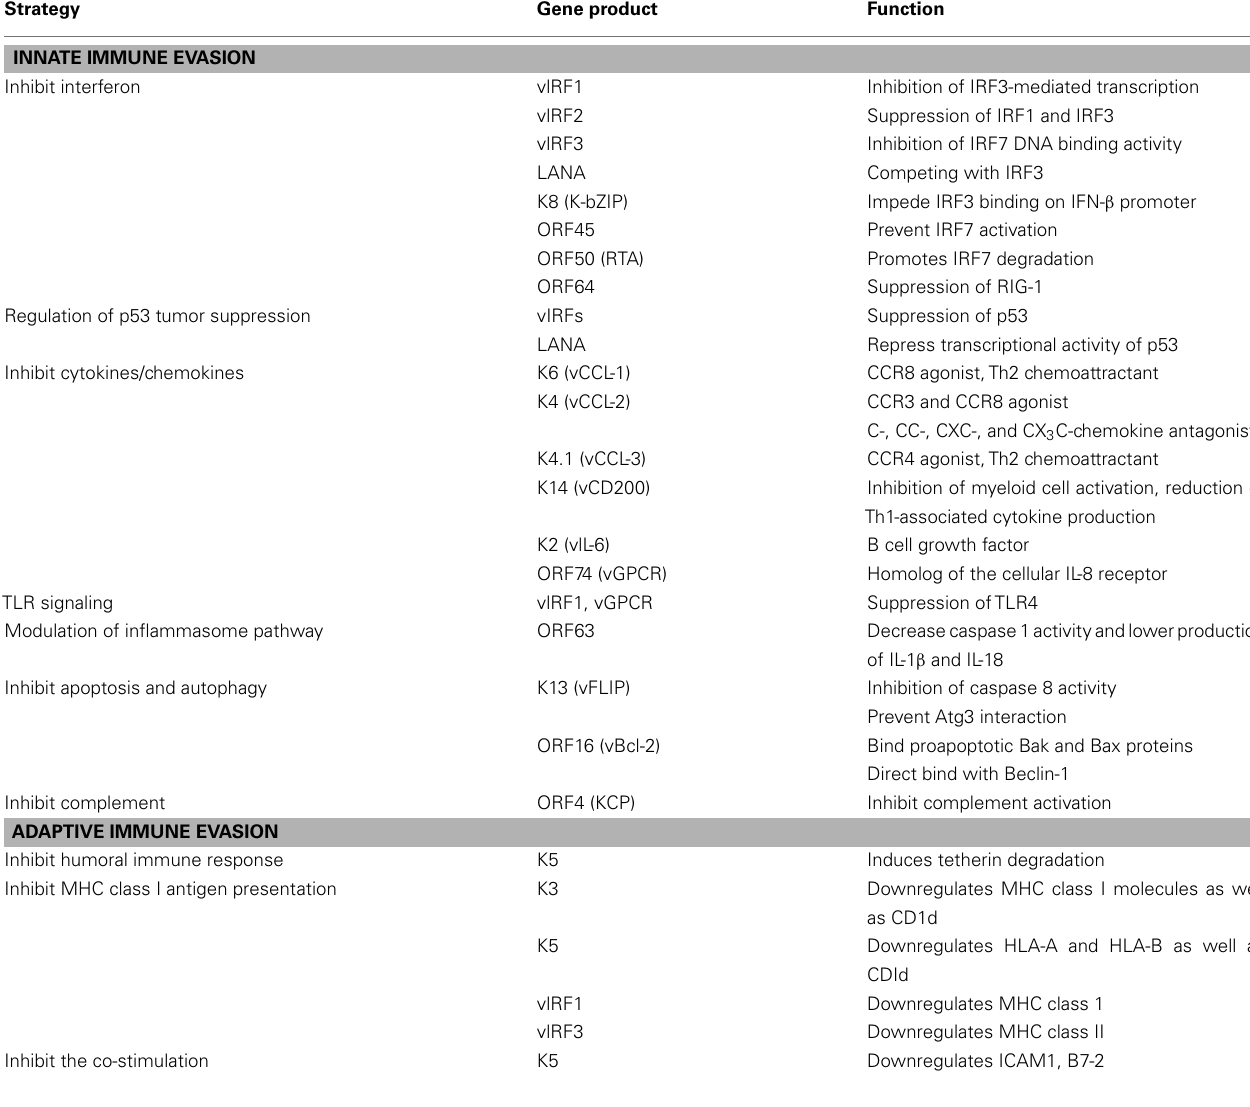
Table 1 |Anti-immune strategies of